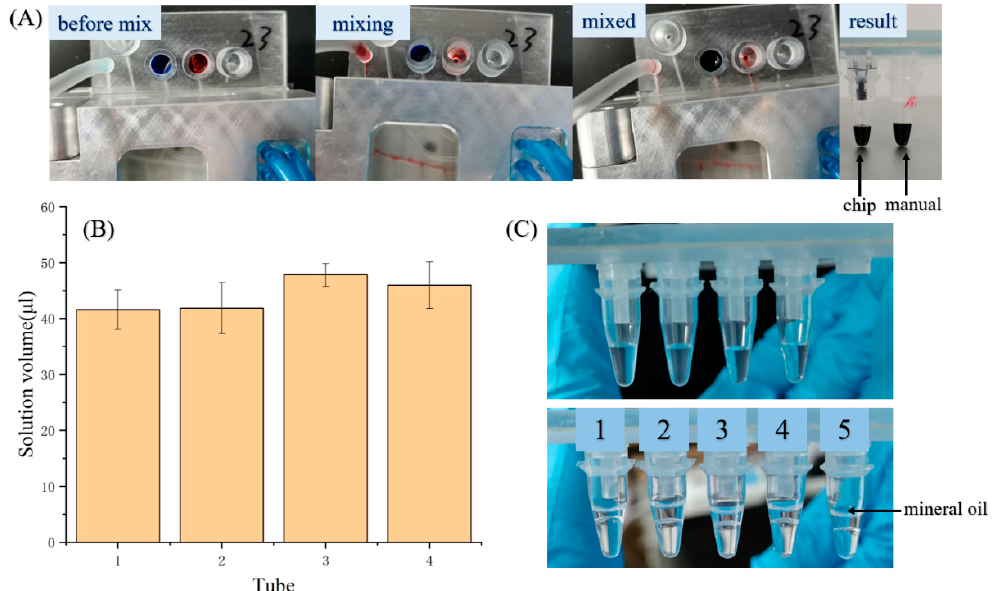
Figure 5. ( A ) Snapshots of dispensing process. ( B ) The reagent volume in PCR tubes after the preparation with the device. n = 3. ( C ) Photograph of the prepared reagents in the PCR tubes.